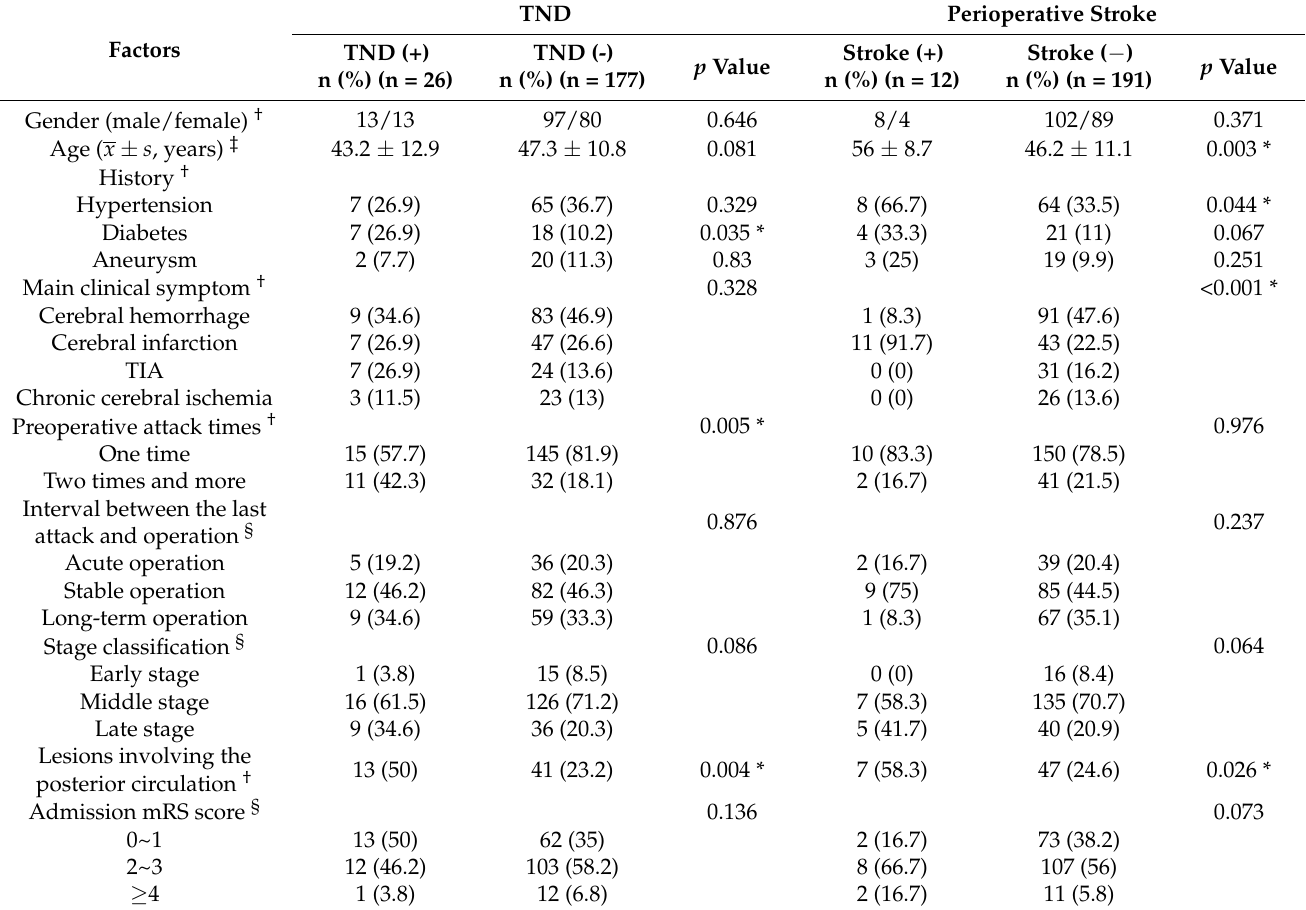
Table 4. The univariate analysis of perioperative complications after revascularization in 203 oper- ations.